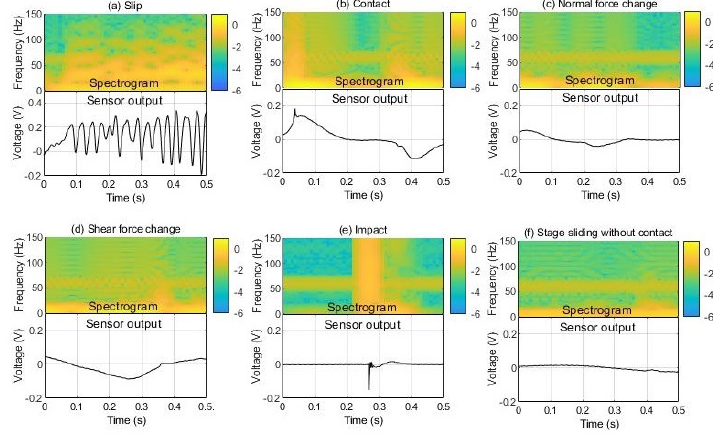
Figure 6. Slip and nonslip training data.